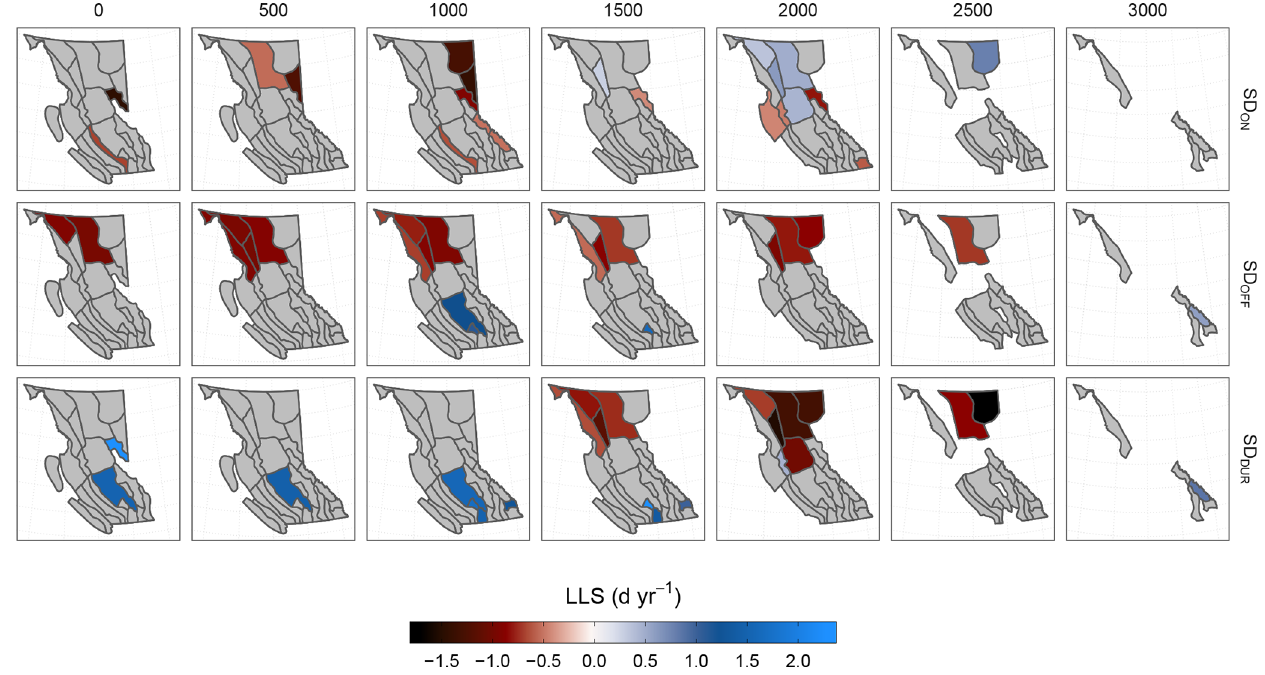
Figure 12. Map of BC showing the rate of change in days per year (dyr − 1 ) of the MODIS-derived SD ON , SD OFF , and SD DUR (vertical groups) by hydrozone and by elevation group of 500m (horizontal groups). Grey zones have insignificant trends ( p value > 0 . 05); missing zones have no terrain in the given elevation